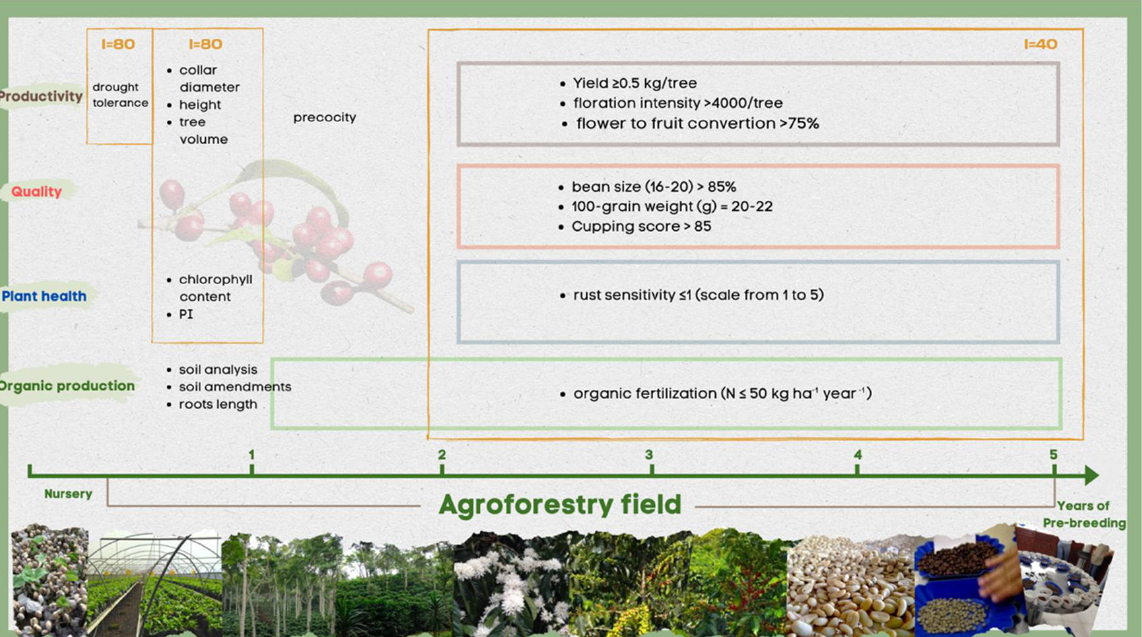
Figure 4. Methodology for pre-selection of new Arabica hybrid families. Over 5 years, the hybrid families will be evaluated first in the nursery, and then in the agroforestry field (50% shade) by applying different selection indices based on the criteria defined as the desired ideotype. (i = selection index).